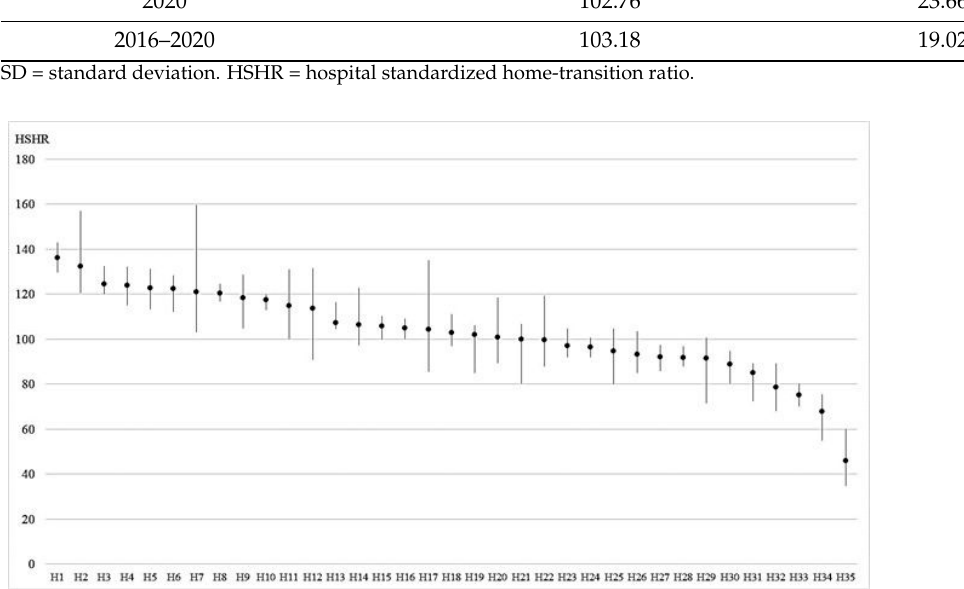
Figure 2. Mean and width * of HSHR in each hospital. H = hospital. HSHR = hospital standardized home-transition ratio. *Width means the range between the minimum and maximum HSHR. Table 6. Correlation between the HSHRs in each consecutive year. Period r